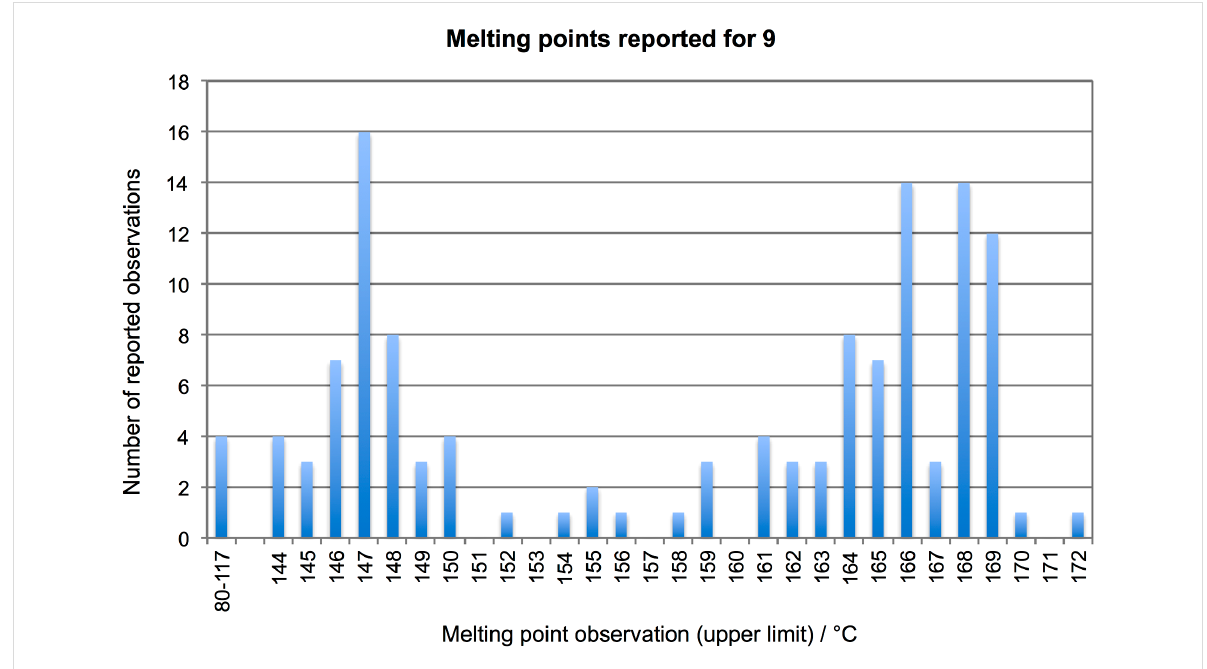
Figure 1: Frequency of reported melting points for acetaldehyde 2,4-dinitrophenylhydrazone ( 9 ) from the Reaxys database (June 2017). Where a melting-range had been reported, the upper limit was chosen for the analysis.